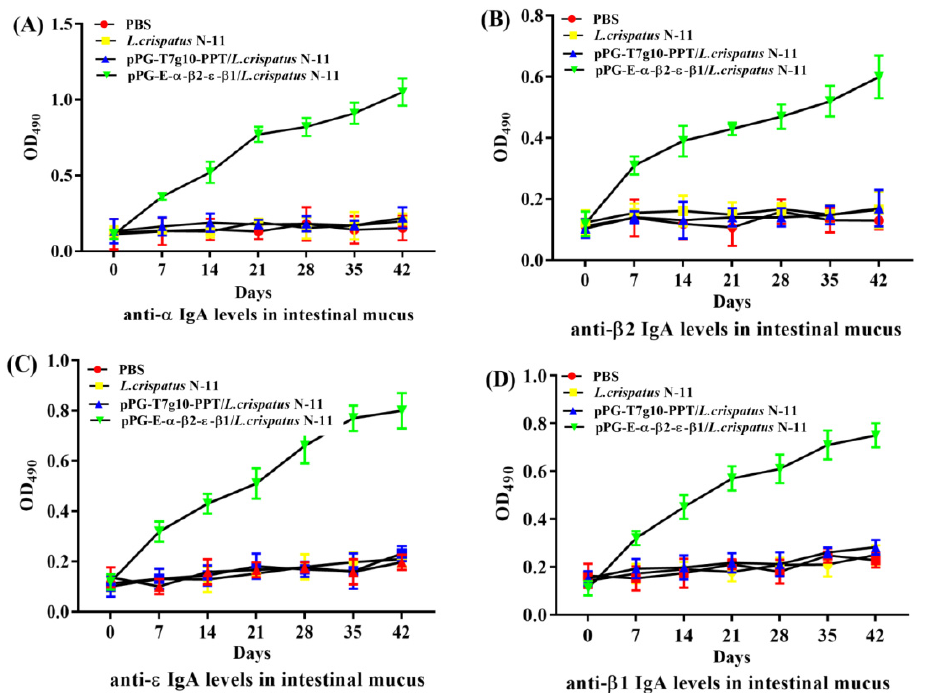
Figure 3. Antigen-specific IgA antibody levels in intestinal mucus of chickens immunized with pPG-E- α - β 1- ε - β 2/ L. crispatus N-11 was analyzed using ELISA. The intestinal mucus samples ( n = 3) were collected on days 0, 7, 14, 21, 28, 35, and 42 from each group of chickens. ( A ) Anti- α specific IgA; ( B ) anti- β 2 specific IgA; ( C ) anti- ε specific IgA; ( D ) anti- β 1 specific IgA. Data are presented as the mean ± standard error in each group.